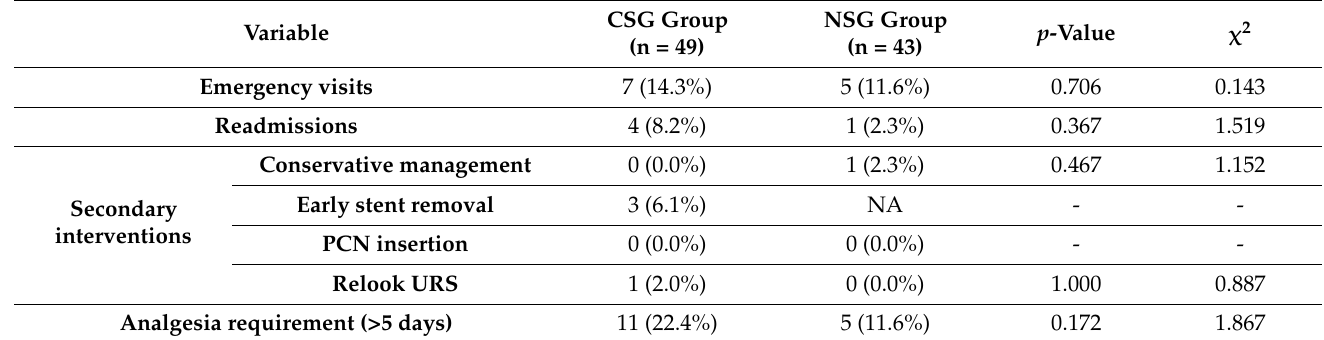
Table 4. Postoperative complications in CSG and